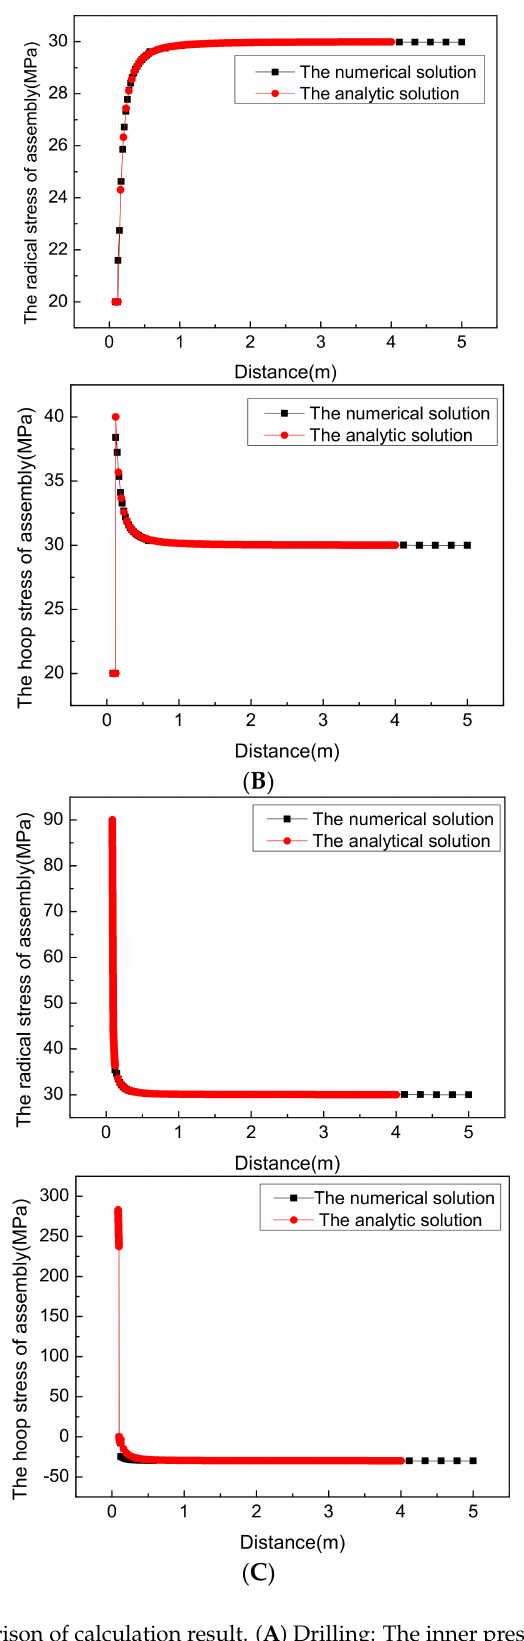
Figure 4. Curve comparison of calculation result. ( A ) Drilling: The inner pressure is 20 MP; geo-stress is 30 MPa; ( B ) Cementing: The inner pressure is 20 MPa; ( C ) Hydraulic fracturing: The pump pressure is 90